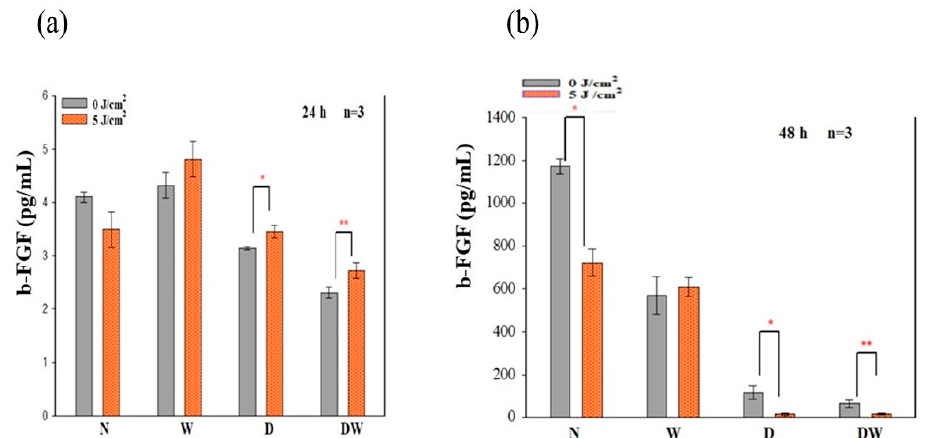
Figure 5. Concentration of bFGF release in media observed in non-irradiated and irradiated normal (N), wounded (W), diabetic (D), and diabetic wounded (DW) cell models at 24 h ( a ) and 48 h ( b ) following irradiation at 660 nm with a fluence of 5 J/cm 2 . Data are expressed as ±SEM (n = 3). Significant probabilities compared to the non-irradiated controls are shown as * p < 0.05, and ** p < 0.01.